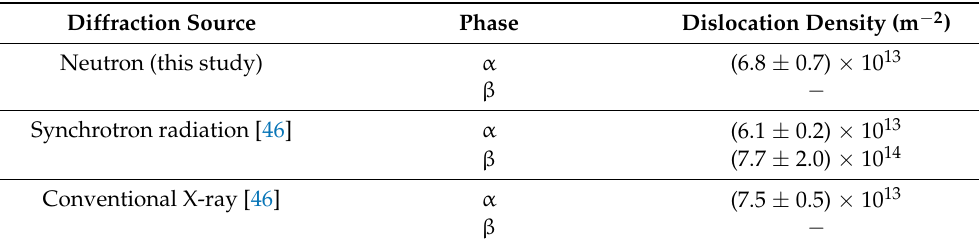
Table 3. Dislocation density of the as-built Ti–6Al–4V specimen, as determined via TOF-ND measure- ments and CMWP method. For comparison, those obtained from conventional and synchrotron XRD measurements [46] are also